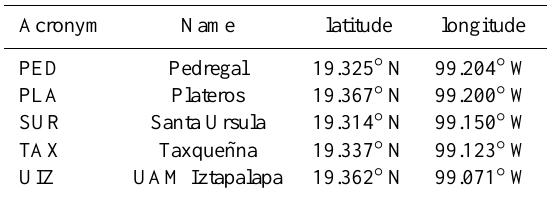
Table 4. Insitu measurements of CO. Five sites of the air quality monitoring network (RAMA) are used to determine the mean CO surface concentration at